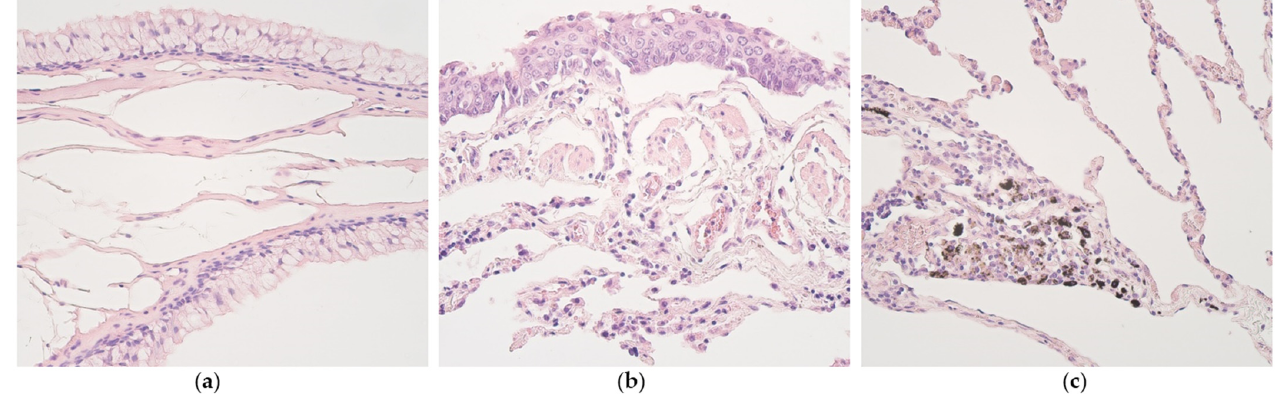
Figure 1. ( a ) Goblet cell hyperplasia seen in lung tissue of a 54-year-old male. Hematoxylin and eosin, X200. ( b ) Metaplastic bronchial epithelium seen in lung tissue of a 93-year-old male. Hematoxylin and eosin, X200. ( c ) Dust-containing macrophages seen in lung tissue of a 19-year-old male. Hematoxylin and eosin, X200.